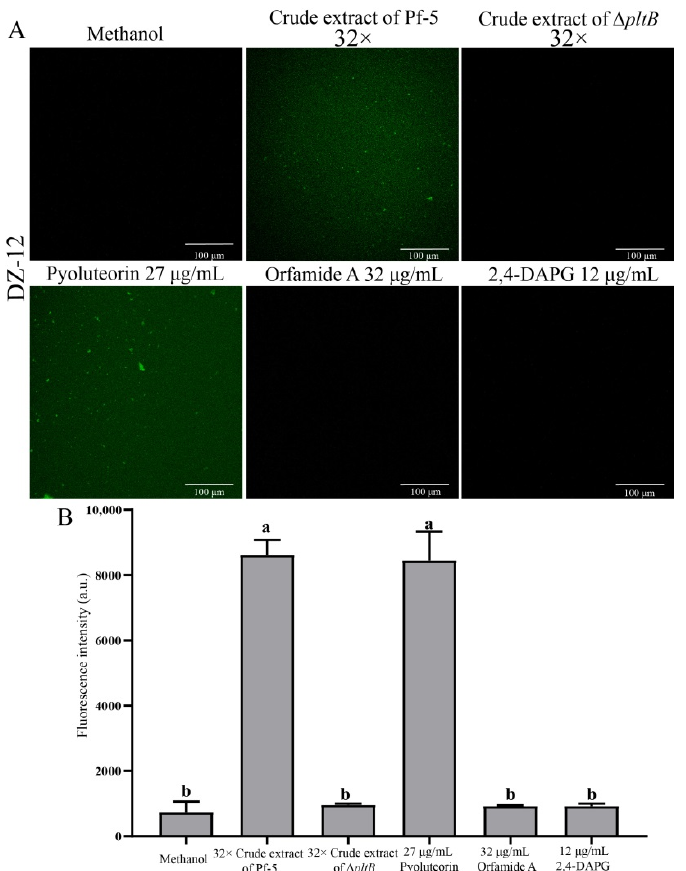
Figure 5. The effects of crude extract on ROS production P. ananatis DZ-12 observed using a Leica SP5 confocal microscope ( A ), and analyzed by EnSight Multimode Plate Reader ( B ). A concentra- tion of 32× dilutions of the crude extract from P. protegens Pf-5 and its mutant Δ pltB were used. A concentration of 27 μ g/mL pyoluteorin, 32 μ g/mL orfamide A, and 12 μ g/mL 2,4-DAPG were also used. The graph data show the average fluorescence intensity value ± standard deviation of three replicates. Different letters represent statistically significant differences according to the one-way ANOVA test ( p < 0.05).